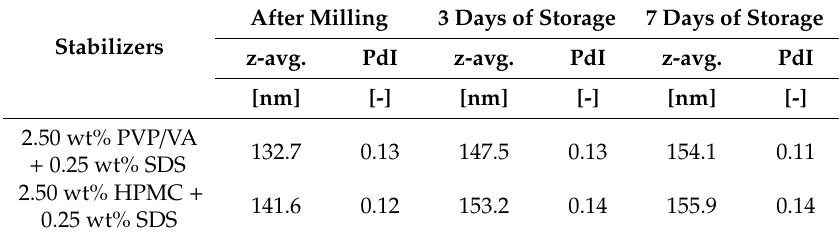
Table 4. Particle size (i.e., z-average) and PdI of the naproxen nanosuspensions directly after milling and after storage at ambient